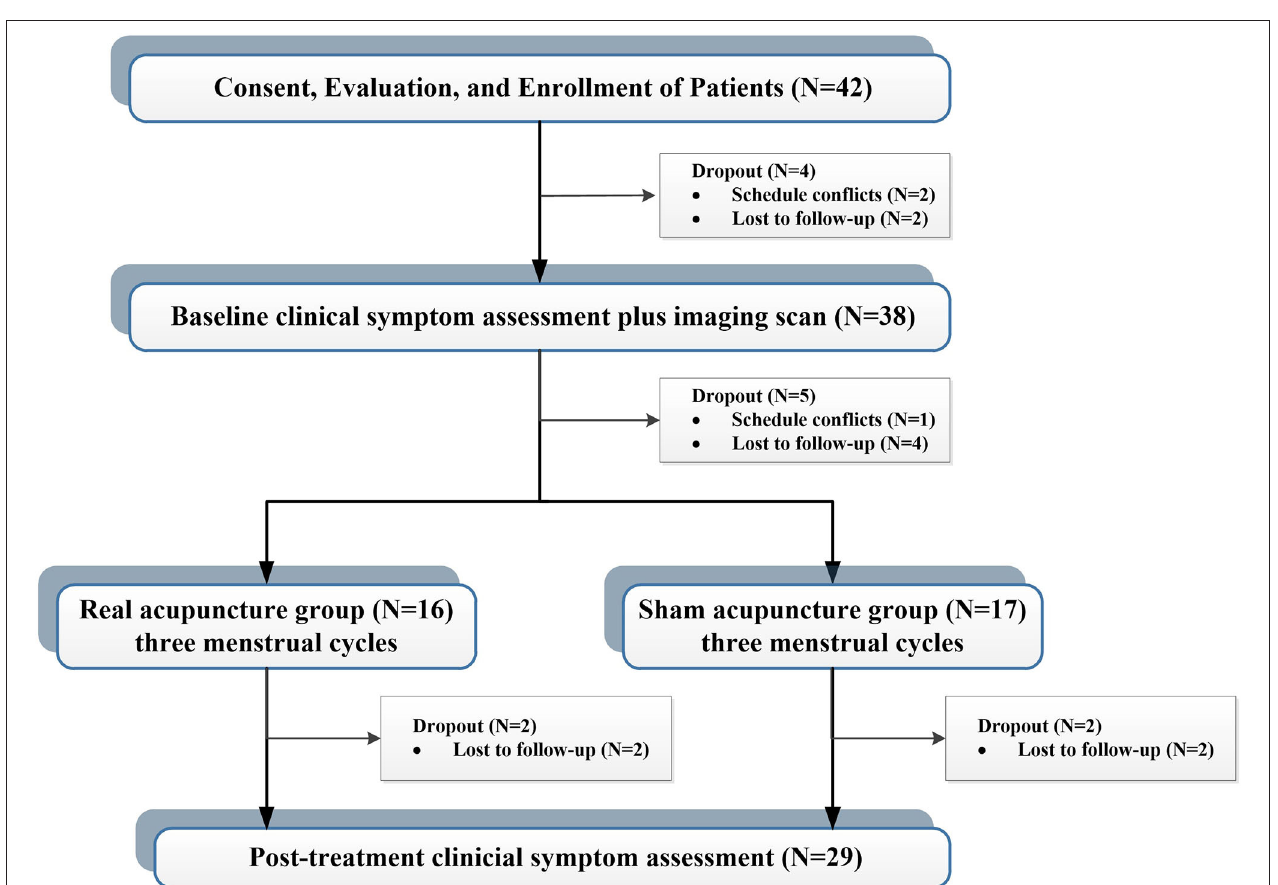
FIGURE 1 | Study design and research flow